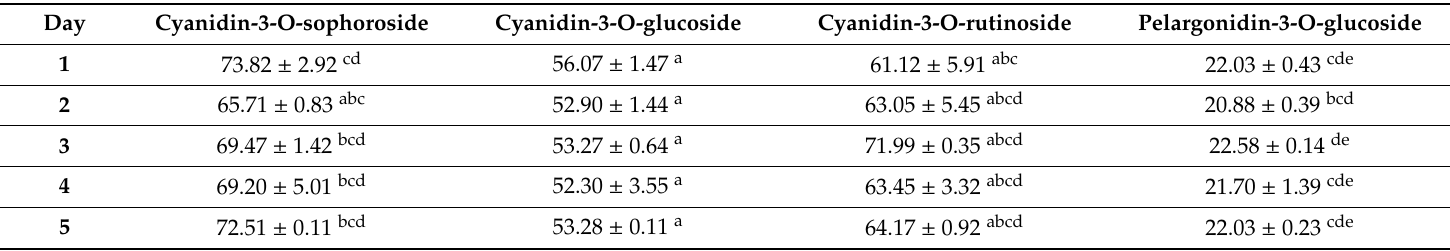
Table 14. Fruits stored at 1 ◦ C in fridge, packaged in Nanoactive A film. E ff ect of storage period on the di ff erent anthocyanidin compounds content in red raspberries (cv. Erika). Results are expressed in µ g / g of fresh weight. The results are the mean of three replicates ± Standard Deviation. ** ( P ≤ 0.01); * ( P ≤ 0.05); n.s. (not significant). The letters represent the significant di ff erence vertically at P ≤